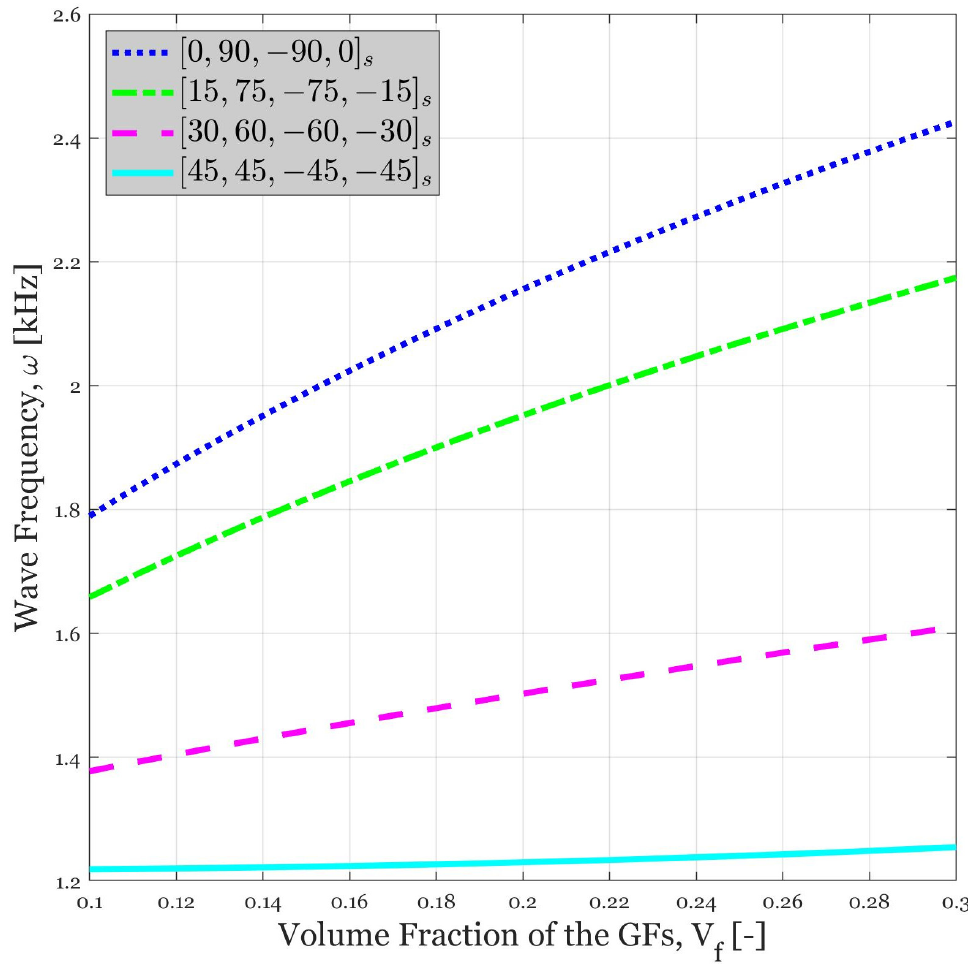
Figure 5. The variation in the wave frequency versus volume fraction of the GFs for various lay-ups of eight-layered laminates ( β = 2).